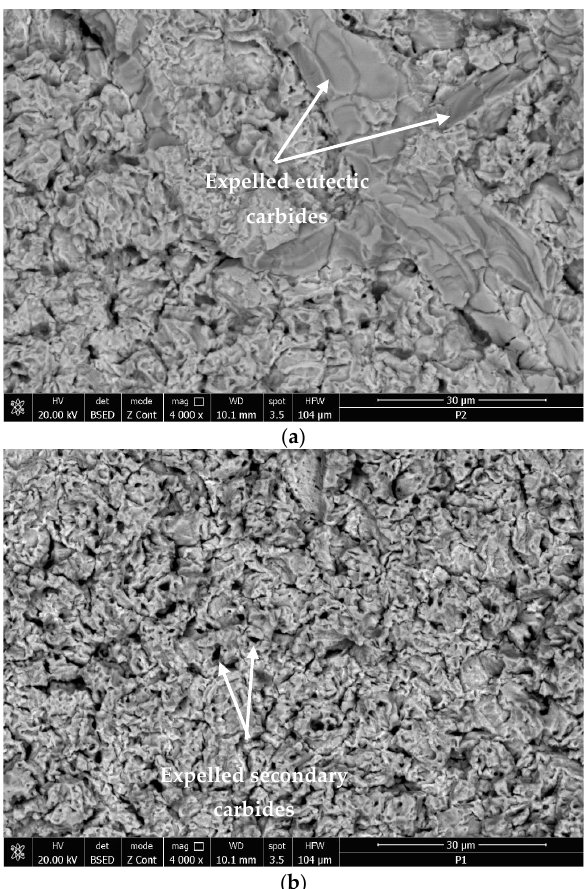
Figure 15. The microfractographic image of the cavition surface for 165 min. ( a ) — annealed structural state; ( b ) — TIG surface remelting with Is = 150 A.